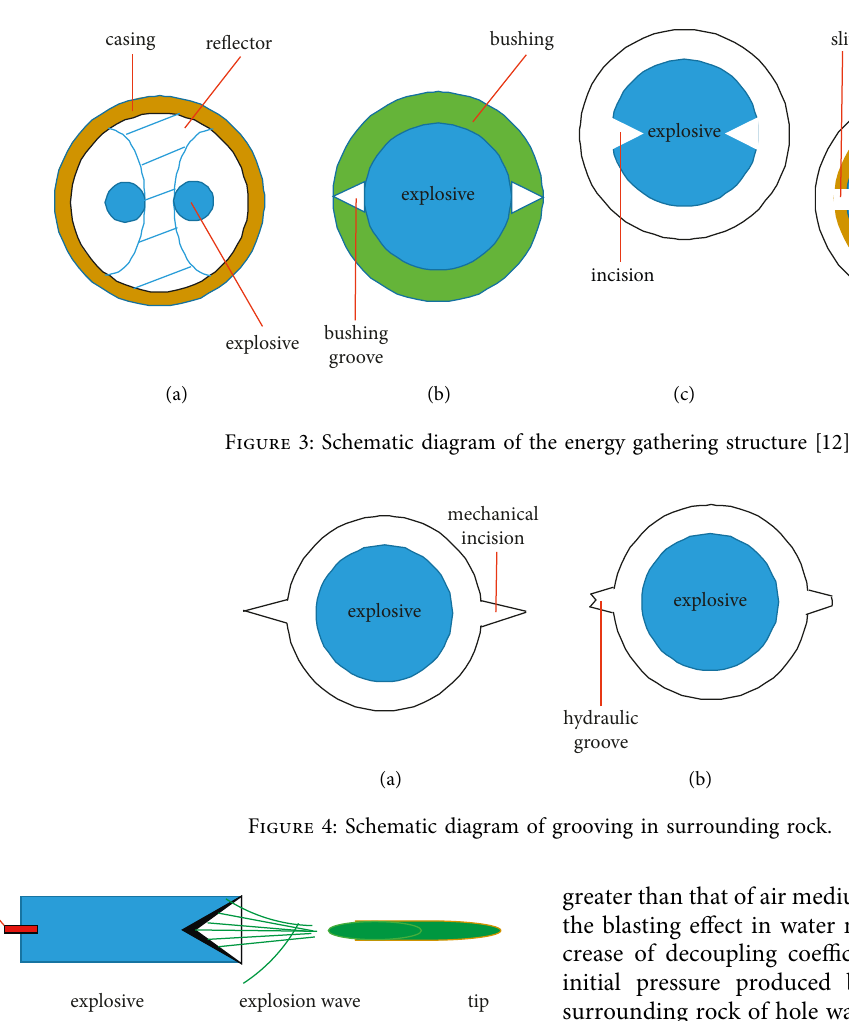
Figure 5: Energy-concentrated